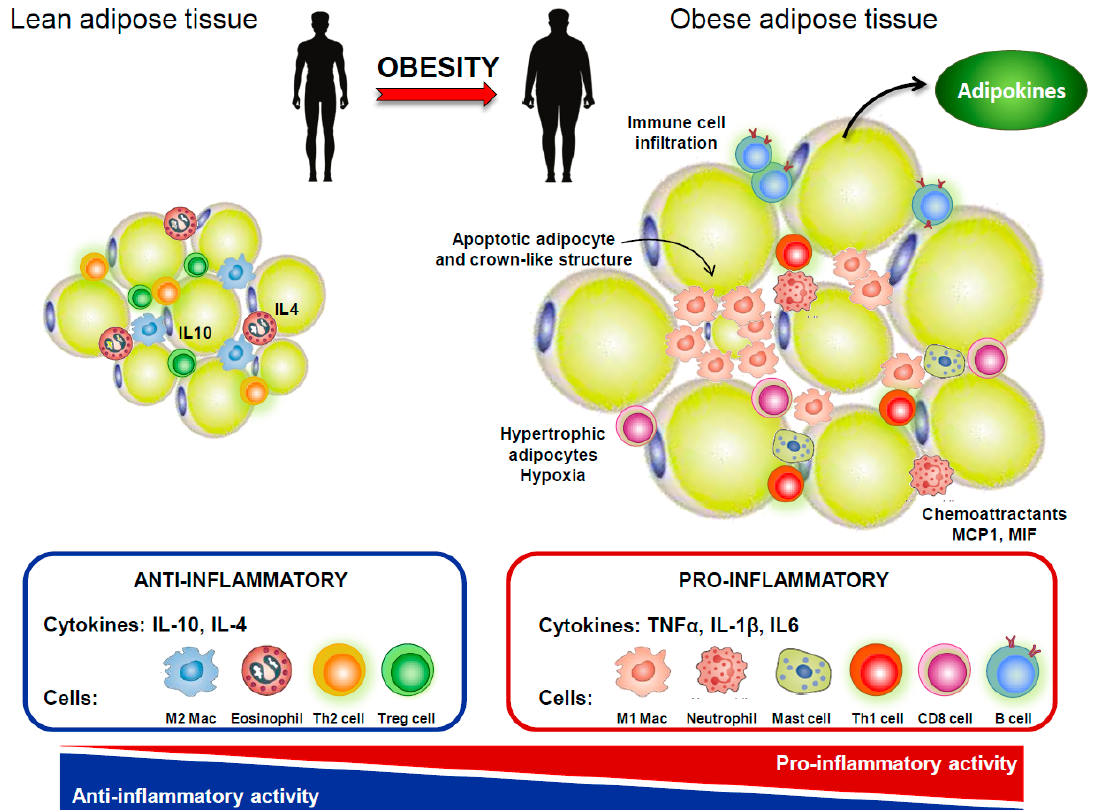
Figure 2. White adipose tissue as a pro-inflammatory tissue. In lean adipose tissue, the cross-talk between adipocytes and immune resident cells maintains tissue homeostasis. In particular, Treg cells secreted anti-inflammatory cytokines (IL10 and IL4) that promotes M2 macrophage phenotype. Overnutrition results in WAT expansion and adipocyte hypoxia, with consequent production of chemoattractants and infiltration of immune cells. B and T cells cells become activated, and there is a phenotypic switch from M2 to M1 macrophages, which accumulate around necrotic adipocytes forming ‘crown-like structures’. The deregulated production of adipokines and pro-inflammatory cytokines (TNF- α , IL-1 β and IL-6) contributed to chronic low-grade inflammation.